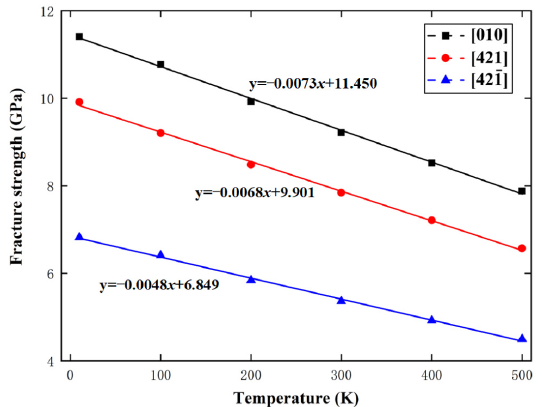
Figure 16. Variations of fracture strength with temperature along the [010] , [421] , and [421] di- rections.